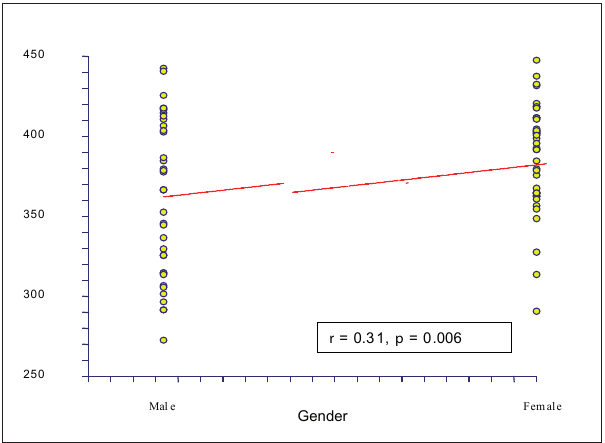
Fig. 1b. Correlation between corrected QT interval and